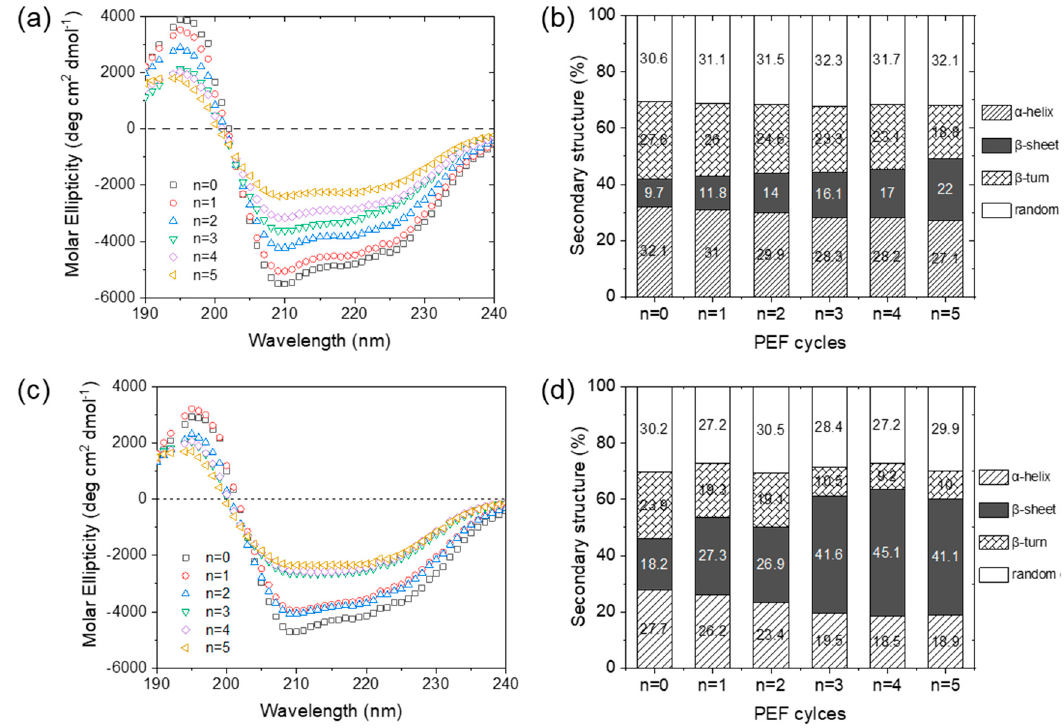
Figure 6. Secondary structure of α -amylase ( a , b ) and α -amylase/ λ -carrageenan complexes with a ratio of 10:1 ( c , d ) after PEF treatment, n represents the number of cycles.